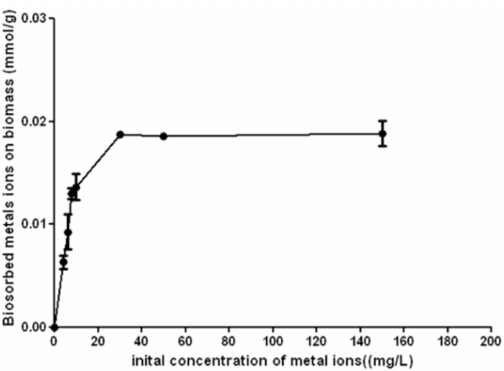
Figure 2. Adsorption isotherm of cadmium on microalgal biomass (pH: 4.0; temperature: 27 ◦ C; biomass dosage: 5